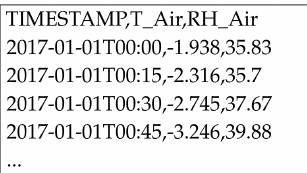
Figure 5. Standardization of the input file: Example of univocal structure for the input data file EuracID00216A_M2paf2200_201701010000201712312345.csv